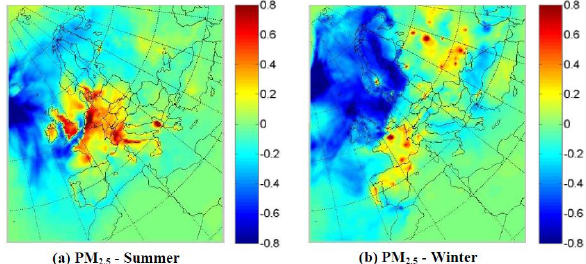
Italy. However in North Europe and also in areas in South- west Europe and in the Balkans, the response of PM 2 . 5